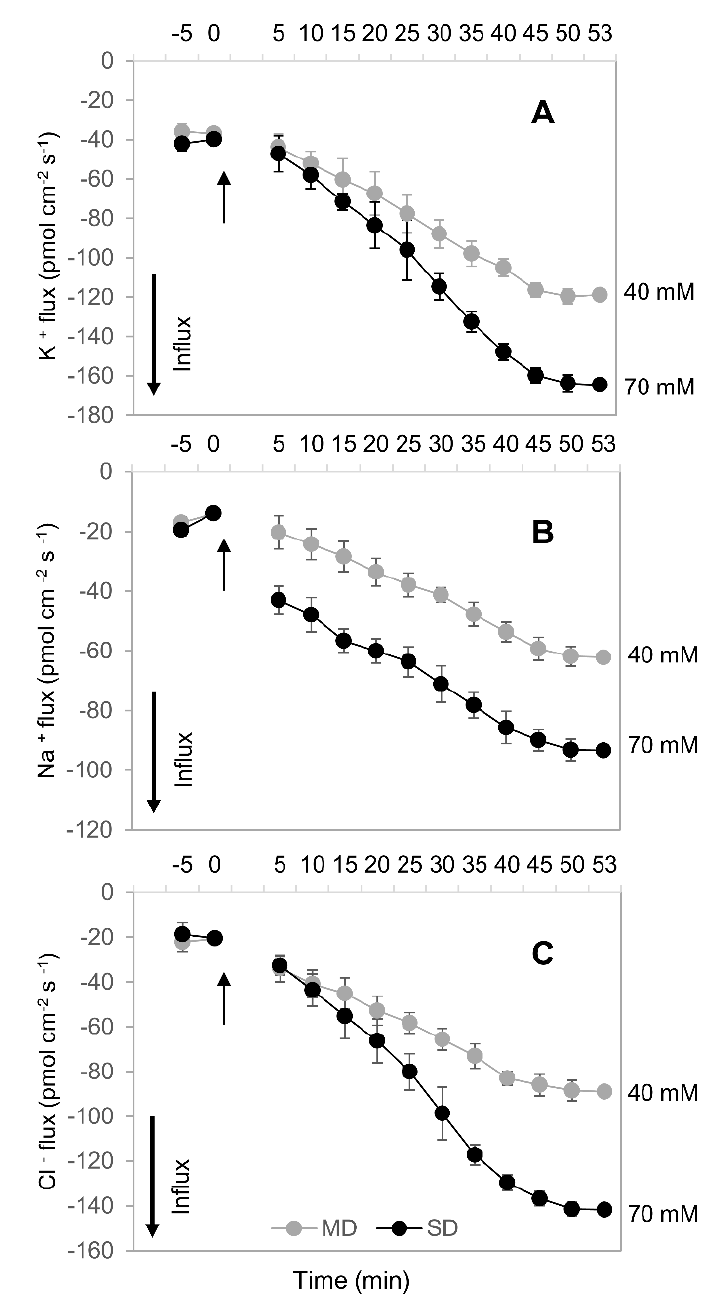
Figure 8. Transient kinetics of net ion fluxes measured from the meristematic region of C. duriuscula roots in response to mild (MD; 40 mM mannitol) and SD (70 mM mannitol) osmotic stress. ( A ) K + flux, ( B ) Na + flux, ( C ) Cl − flux. Data are means ± SE ( n = 3-6). Data labeled with different lower-case letters are significantly different at p <